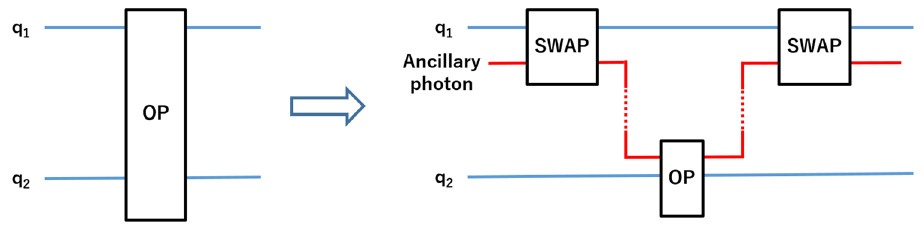
Figure 1. Extending each two-qubit operation on two spin qubits denoted as q 1 and q 2 , to a